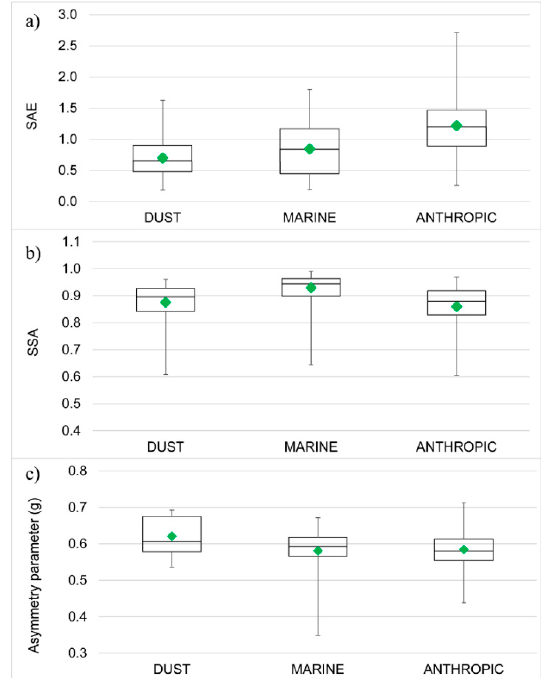
Figure 9. Box and whiskers plots for ( a ) SAE, ( b ) SSA, and ( c ) asymmetry parameter for the three aerosol types studied in this work in an aggregated way. Horizontal black lines are the median value. Boxes represent the 25th and 75th percentile. Whiskers are min and max values. In green (diamond) are the average values for the three measured parameters.